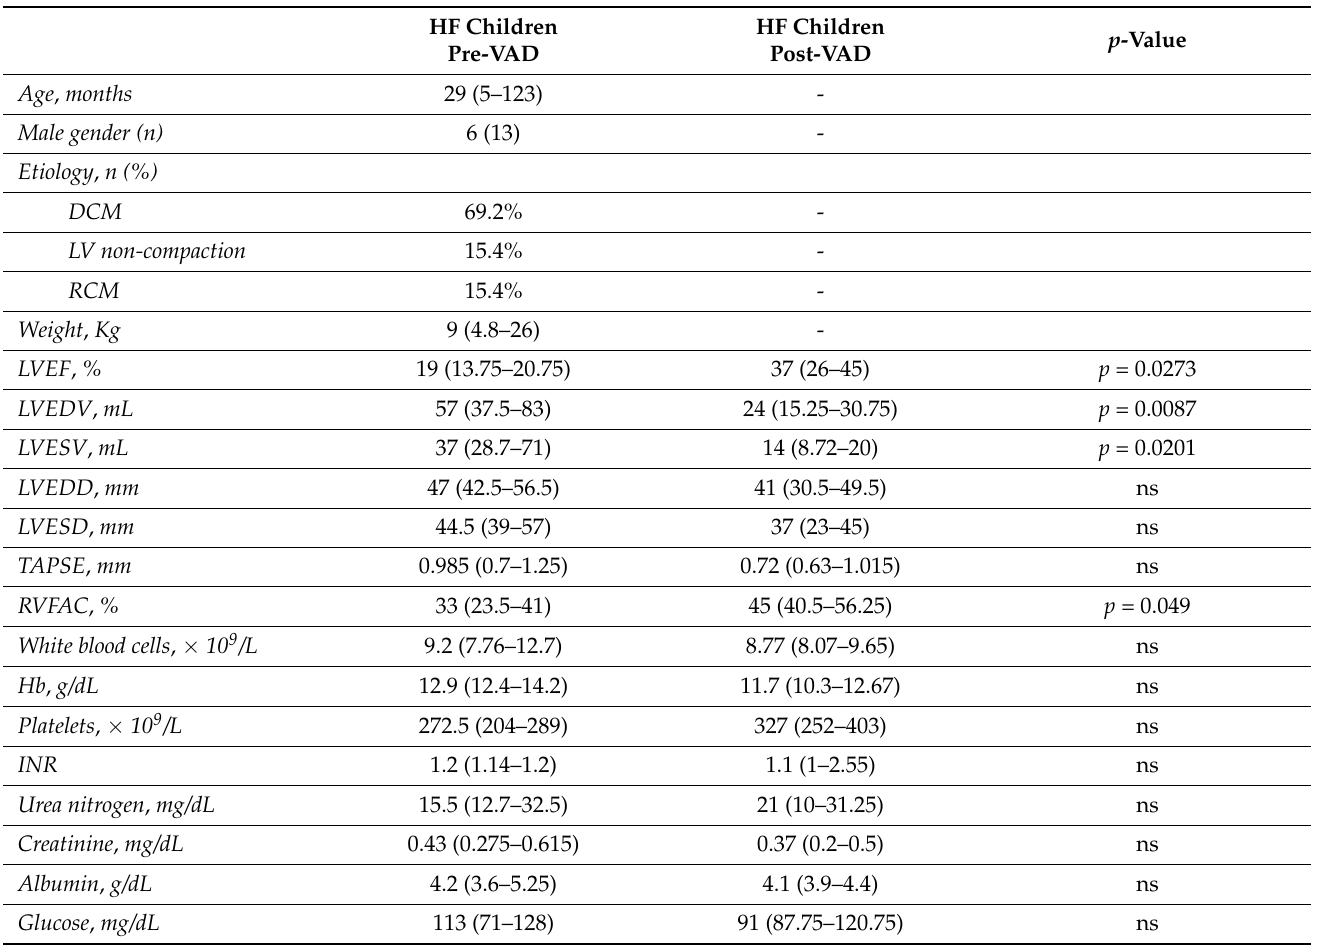
Table 1. Clinical features of HF children at the moment of VAD implant (Pre-VAD) and the moment of heart transplant (Post-VAD). HF